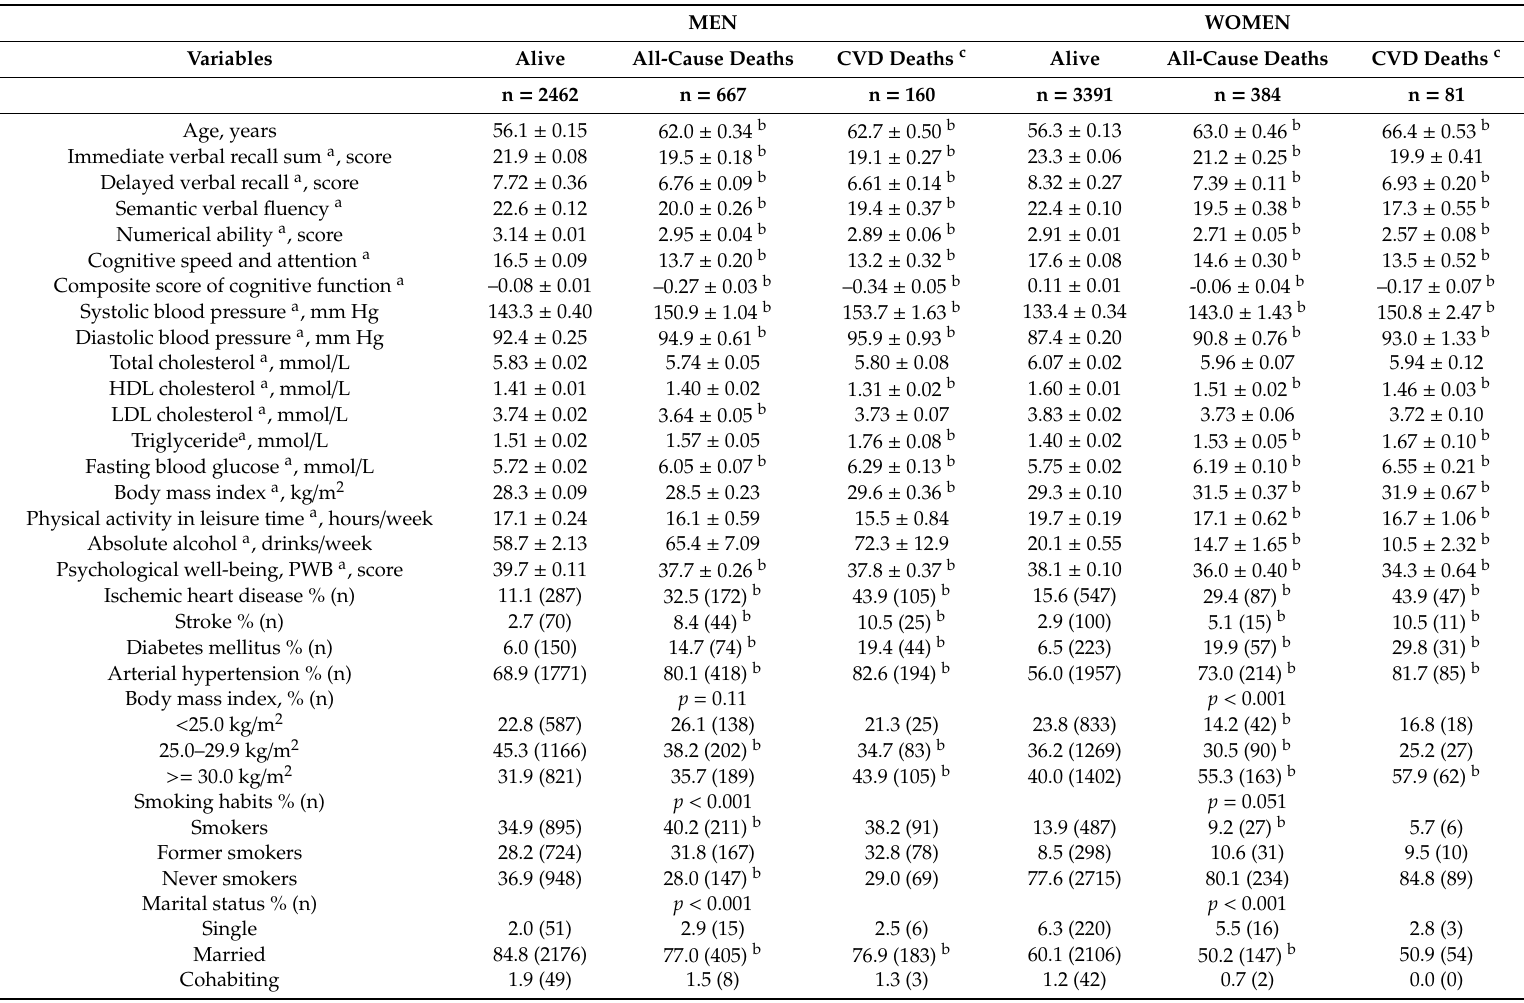
Table 1. Baseline characteristics of the Kaunas Health Alcohol Psychosocial Factors in Eastern Europe (HAPIEE) study sample according to vital status and sex at the end of the follow-up period (31 December